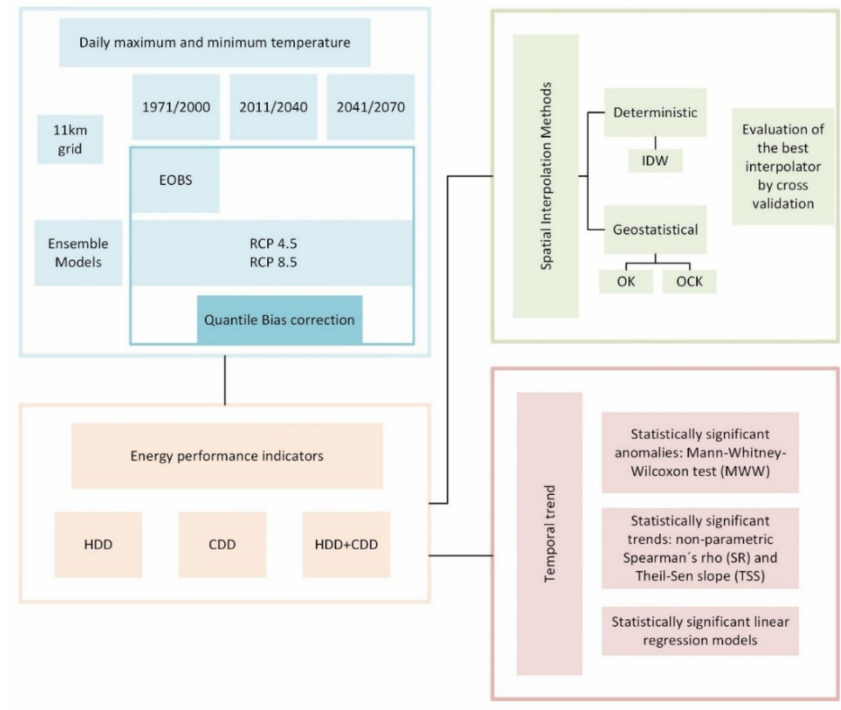
Figure 2. Methodological framework of this